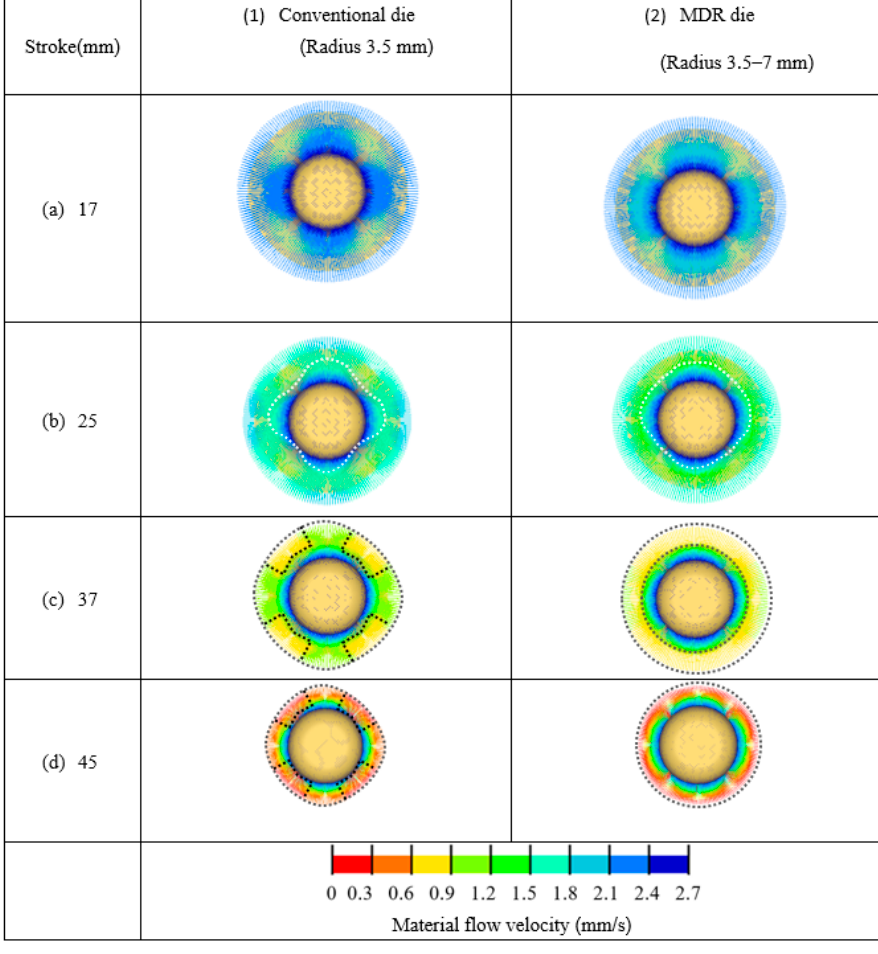
Figure 8. Comparison of the deep drawing mechanism between conventional and multi draw radius (MDR) die applications: ( a ) Die stroke 17 mm; ( b ) Die stroke 25 mm; ( c ) Die stroke 37 mm; ( d ) Die stroke 45 mm.